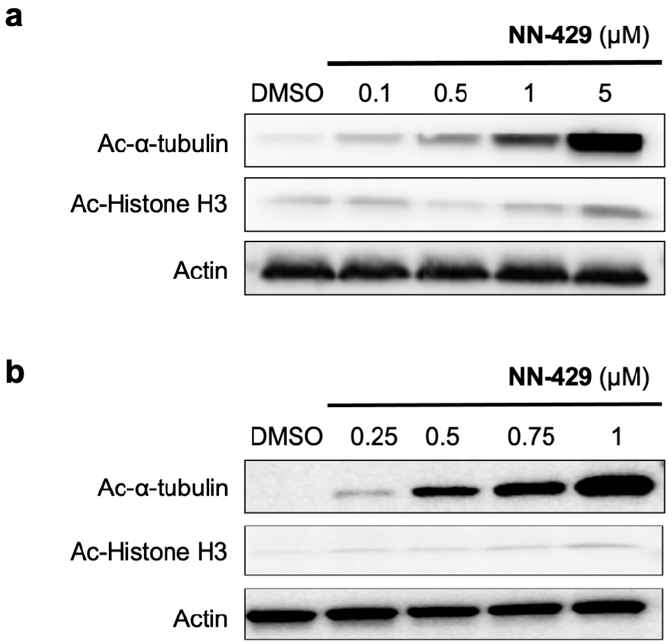
Figure 4. ( a ). Western blot illustrating α -tubulin acetylation and histone H3 acetylation levels in the ( a ) multiple myeloma (MM.1S) and ( b ) acute myeloid leukemia (MV4-11) cell line following 6 h treatment with varying concentrations of NN-429. Protein extracts were prepared, resolved by SDS- PAGE and immunoblotted with acetylated α -tubulin (Ac- α -tubulin), acetylated histone H3 (Ac-His- tone H3) and actin antibodies. Representative Western blots of three independent experiments are shown.